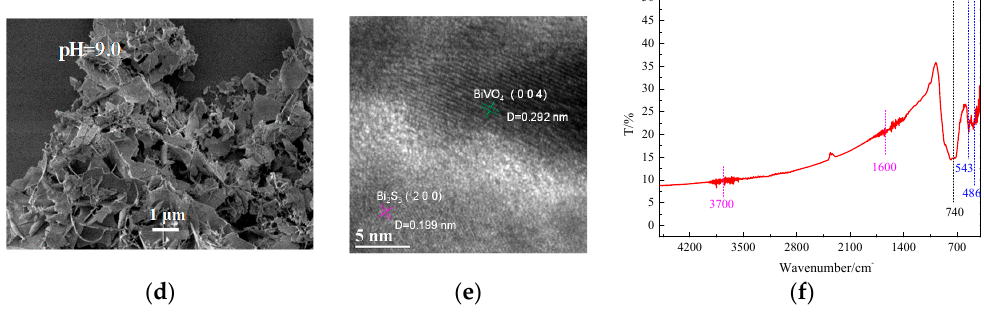
Figure 2. Scanning electron microscopy (SEM) ( a – d ) of samples, HRTEM ( e ) of Sample-8.0, and Fourier–transform infrared (FT-IR) spectra ( f ) of Sample-8.0.